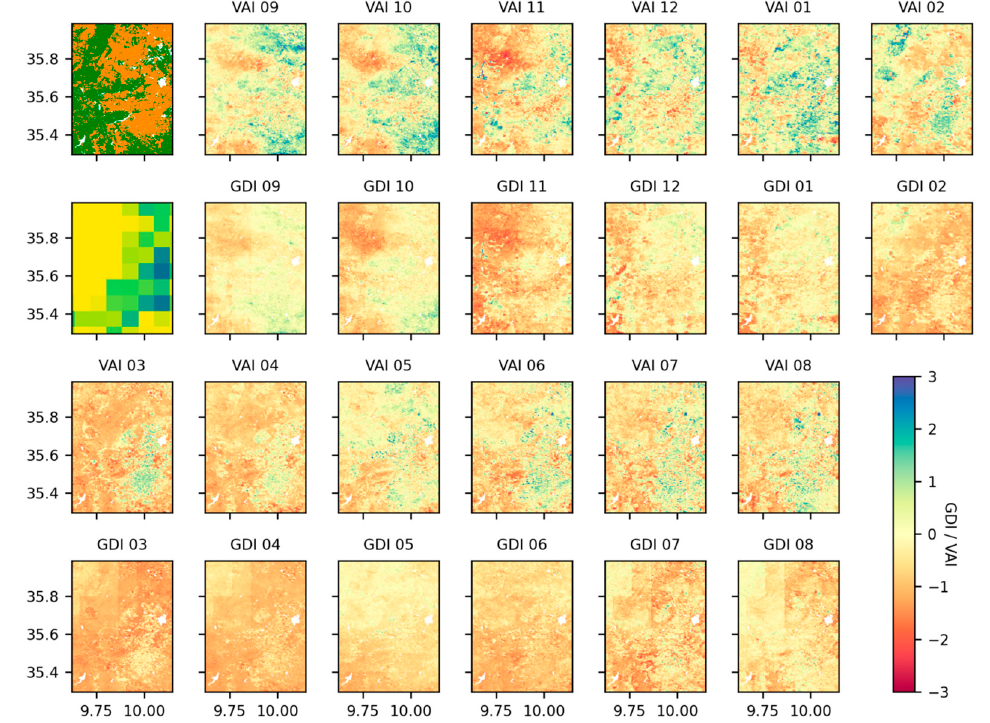
Figure 13. Illustration of maps of land use, irrigation, VAI, and GDI during the 2015–2016 season for each month, from September to August, over the Kairouan site.